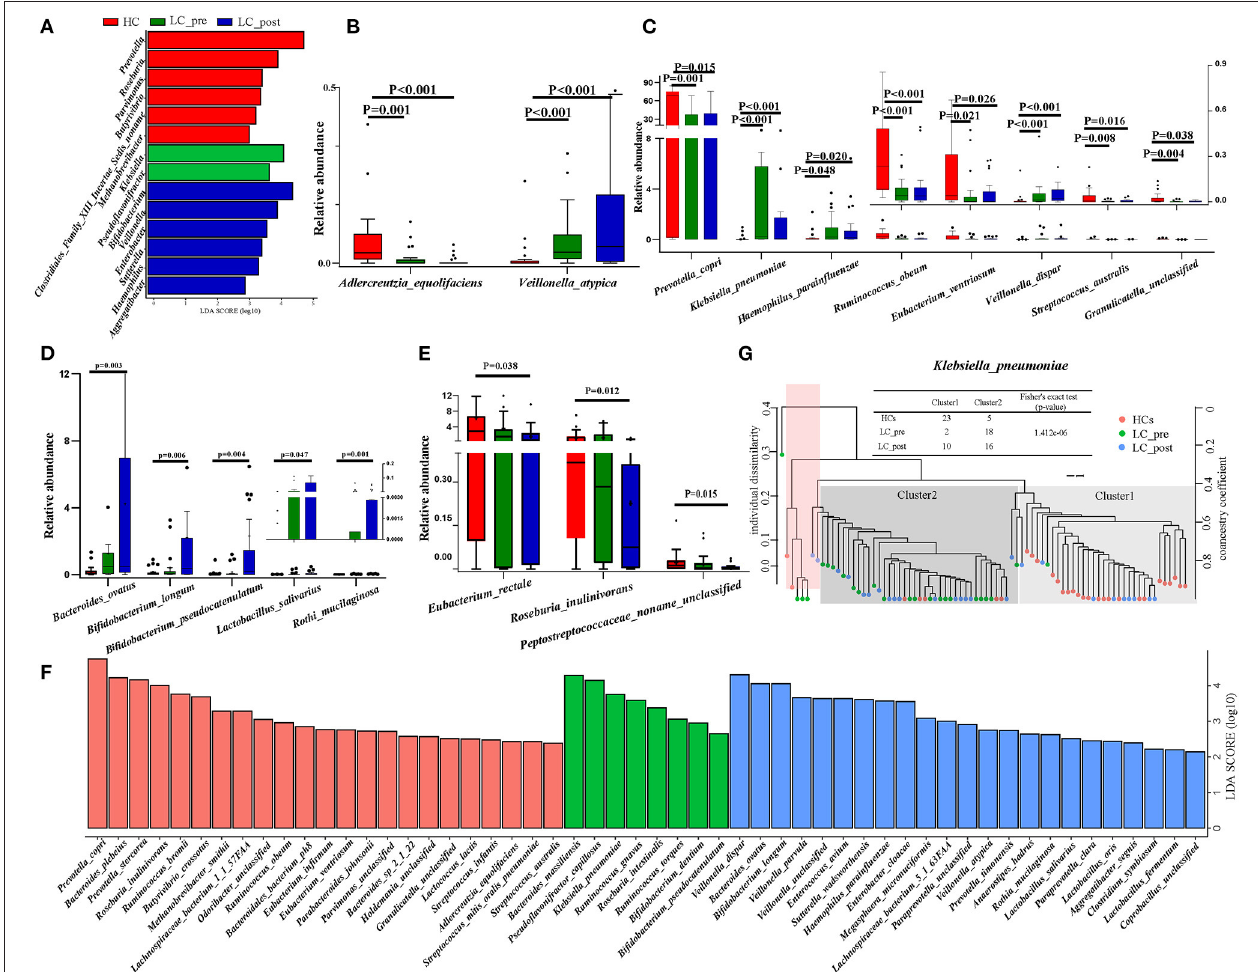
FIGURE 1 | Comparison of intestinal microbial communities in cirrhotic patients before (LC-pre, green) and after (LC-post, blue) lactitol intervention and healthy controls (HCs, red). (A) LEfSe and LDA based on divergent genera between the three groups, which identified the most differentially abundant genera between the three groups. LDA scores of red bars represented genera enriched in HCs, the green represented the LC-pre group, and the blue represented the LC-post group. (B–E) Statistical analysis of differentially abundant species by a non-parametric Kruskal–Wallis test with the Bonferroni correction between the three groups. The box plots indicated the median and 25th to 75th percentiles. (F) LEfSe and LDA based on divergent species between the three groups. (G) Strain-level analysis of K. pneumoniae based on SNPs using the fecal metagenome of subjects in the three groups. LEfSe, Linear discriminant analysis Effect Size; LDA, linear discriminant